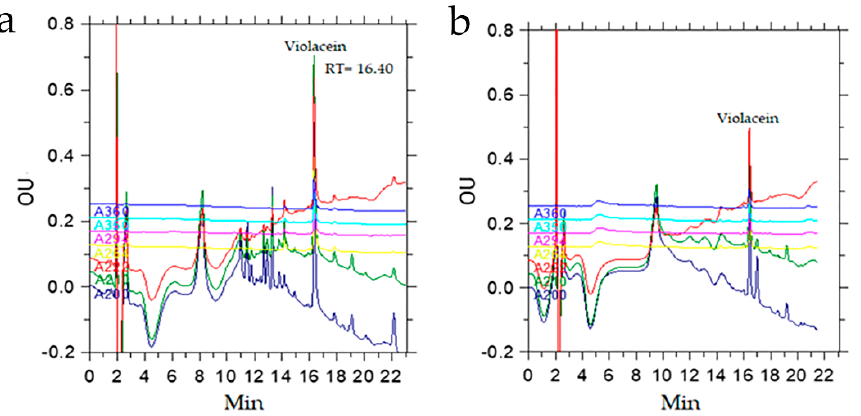
Figure 4. Characterization of the violacein of the Janthinobacterium sp. SLB01 strain extracted by different methods: ( a ) chromatogram of violacein using extraction with n-butanol; ( b ) chromatogram of violacein using extraction with chloroform. OU—optical density in optical units.